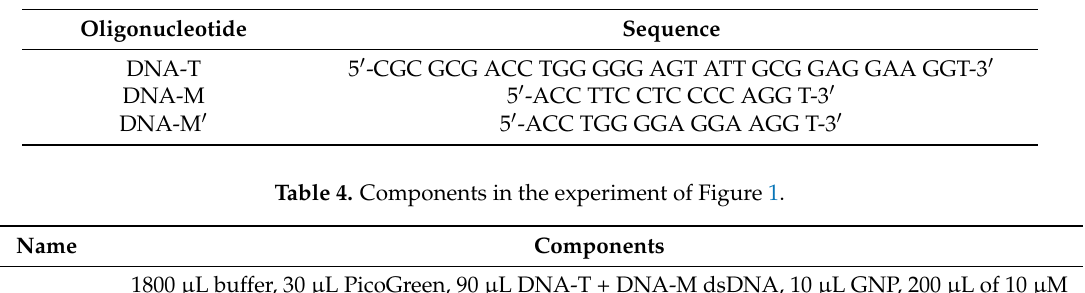
Table 3. DNA sequences.